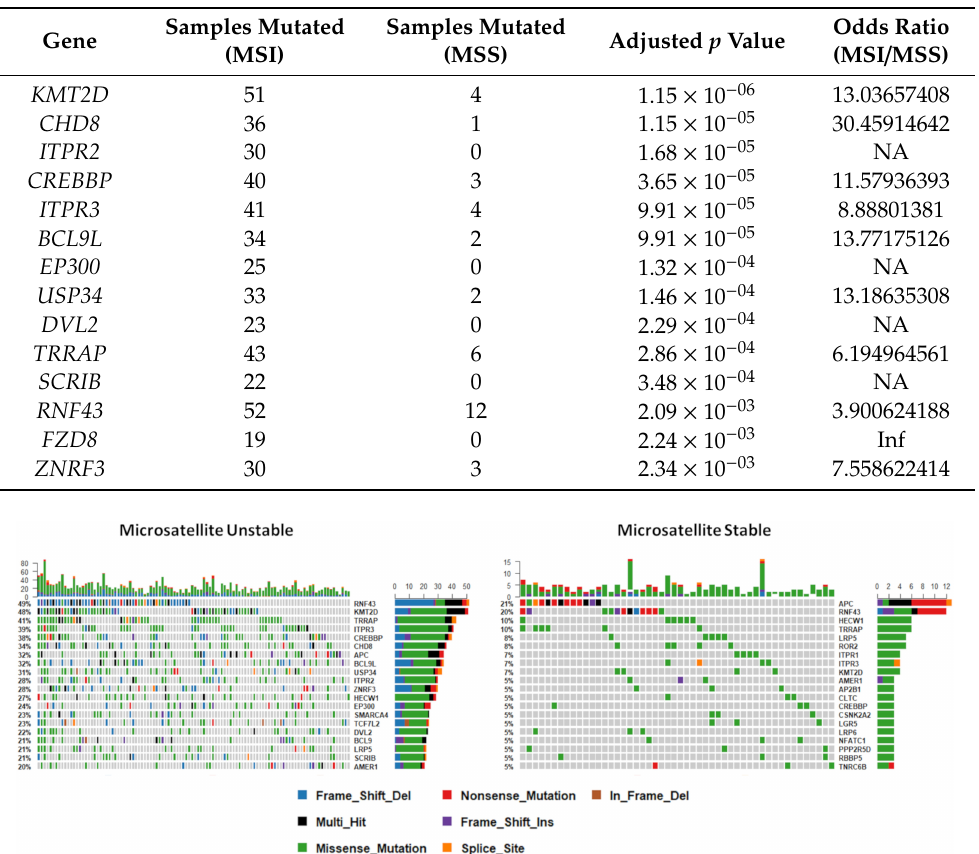
Table 1. WNT signaling regulators that are di ff erentially mutated according to microsatellite instability status in BRAF mutant colorectal cancers.